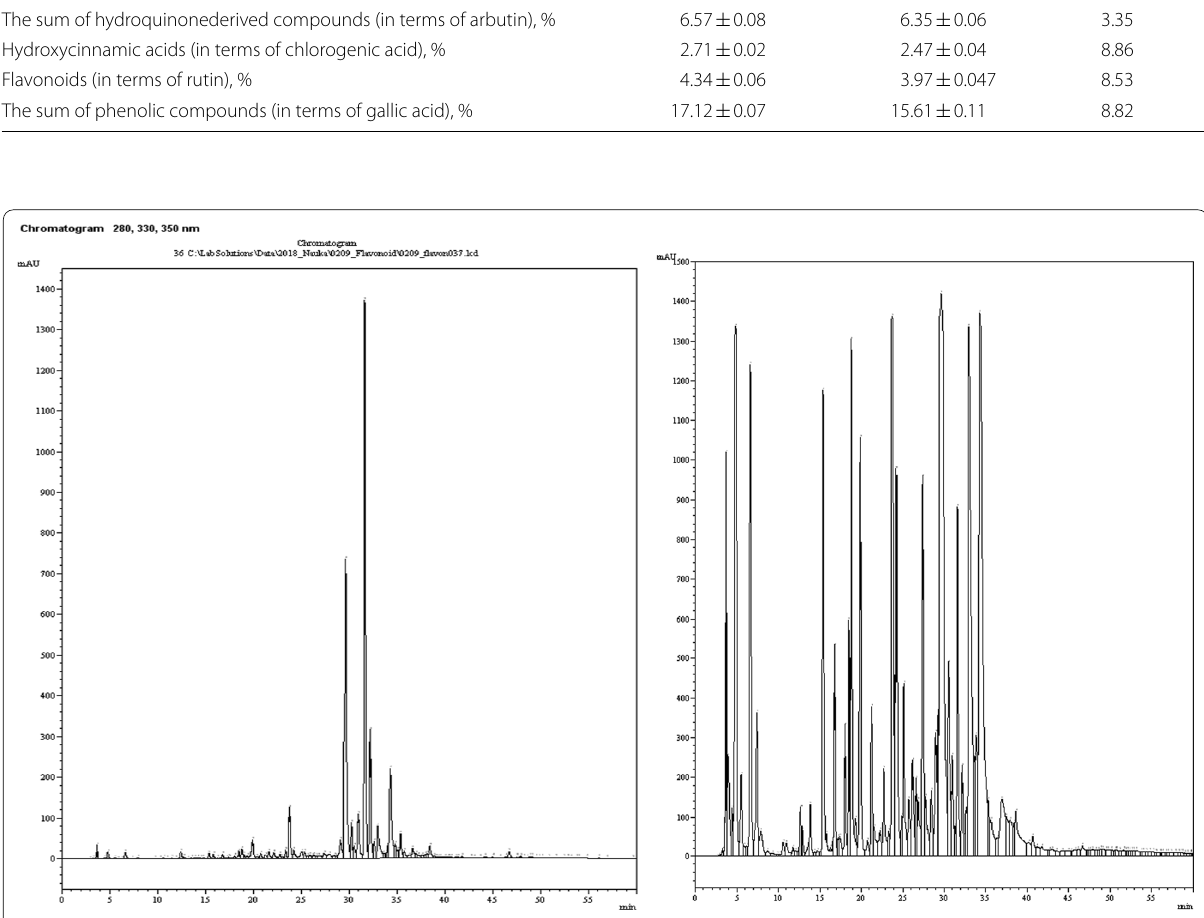
Fig. 1 Typical chromatograms of the bearberry extract